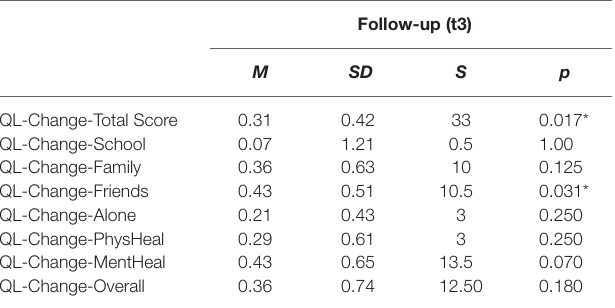
TABLE 4 | Quality of life (change) at the 6-month follow-up ( N = 14).